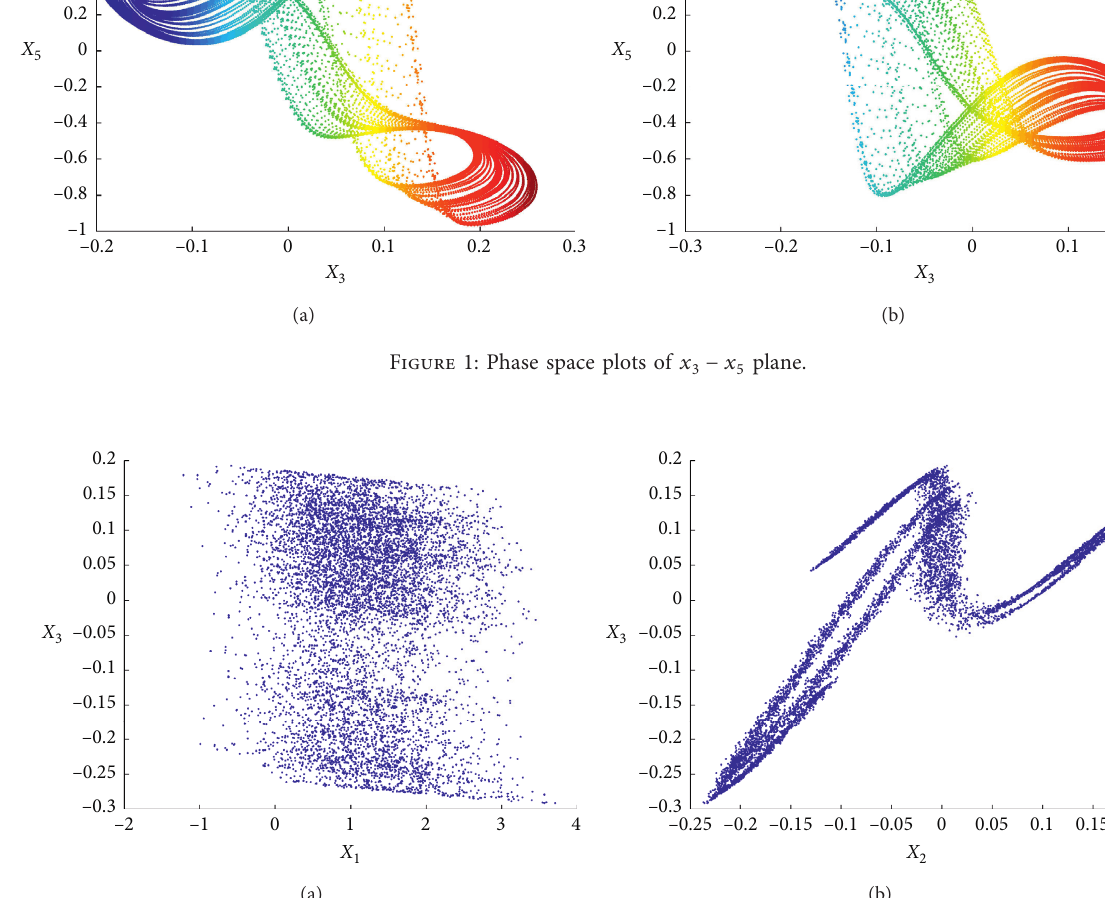
− x − x and x 1 3 2 3